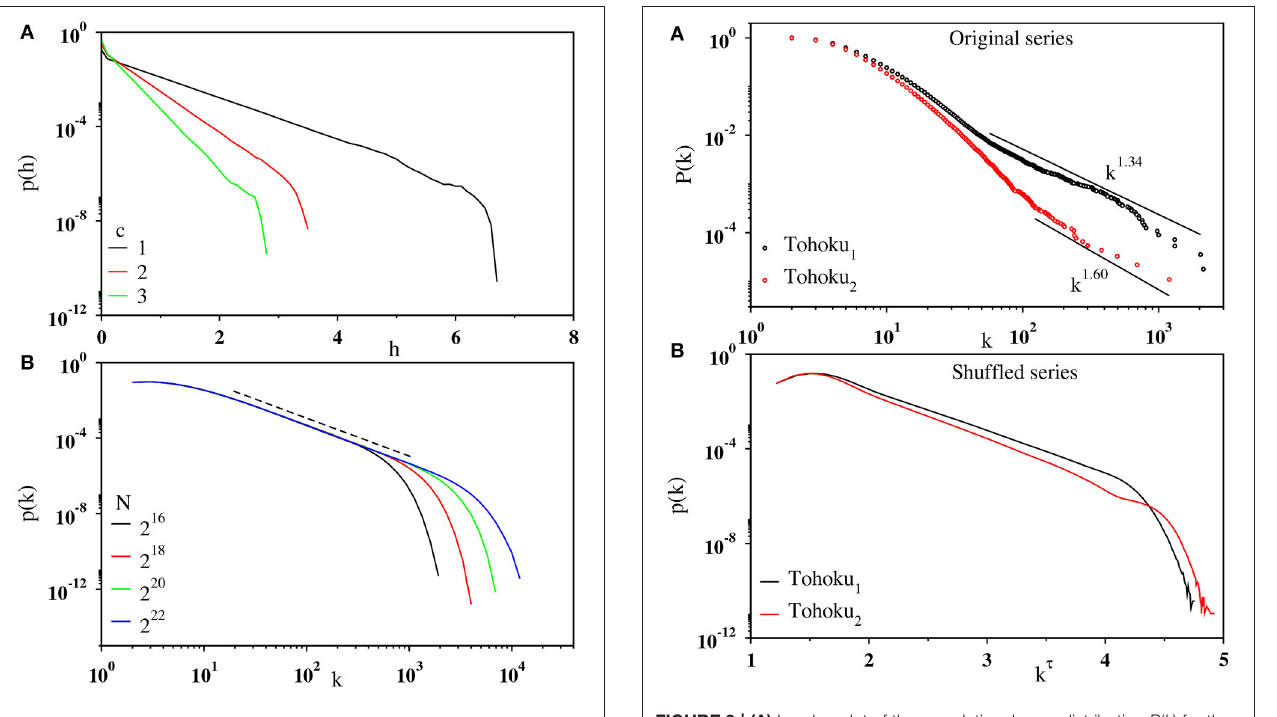
FIGURE 8 | (A) Plot of the height distribution p ( h ) of the time series generated from the Brownian motion of a particle confined in a linear potential U ( x ) on a semilog scale for c = 1 (black), 2 (red), and 3 (green). The slopes of the curves are found to be 1.98(3), 3.95 (3), and 5.98(3), respectively. (B) Log-log plot of the degree distribution p ( k ) of the visibility graph corresponding to the time series of c 1 for N = 2 16 (black), 2 18 (red), 2 20 (green), and 2 22 (blue). = The dotted line is the guide to the eye with slope 2.01. The results are based on the averages of at least 10 3 independent trajectories.